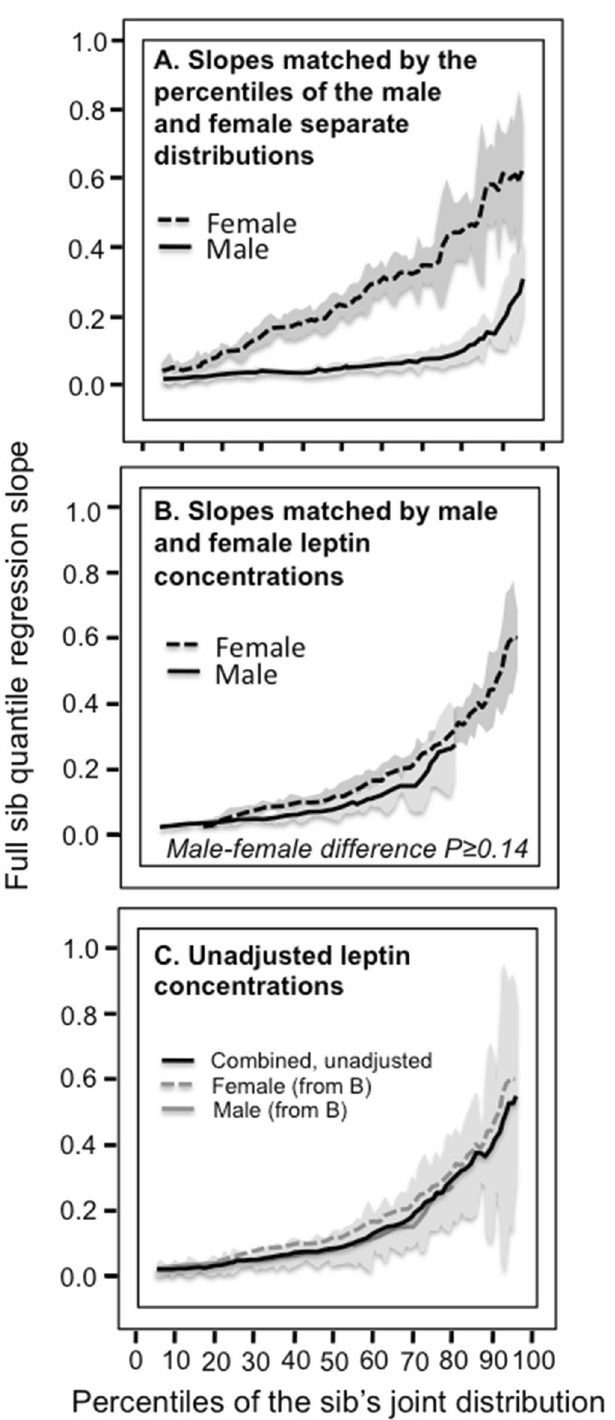
Figure 5. ( A ) Full-sib regression slopes (β FS ) in male and female offspring separately from age- and sex-adjusted male and female pairs, showing their significant difference when the slopes are compared at their corresponding percentiles (the male sibs’ vs. the female sibs’ β FS compared at the 5th percentile of separate distributions, the 6th percentile of their separate distributions, …, 95th percentile of their separate distributions). Shaded area designates ± SE; ( B ) Full-sib regression slopes (β FS ) in male and female sibs showing the significant difference is eliminated when the slopes are compared at their corresponding leptin concentrations (the male sibs’ vs. the female sibs’ β FS translated using probability-probability (P-P) plots to re-plot their leptin concentrations at the 5th percentile of their combined distribution, the 6th percentile of their combined distribution, …, 95th percentile of their combined distribution). Shaded area designates ± SE. ( C ) Full sib regression slopes for male and female sibs combined without adjustment for sex, showing the unadjusted analysis provides a simpler description of the quantile increase based solely on the percentiles of their unadjusted leptin concentrations. Note that the separate curves for male and female sibs fall fully within the 95% confidence interval (shaded area) for their combined sex-unadjusted